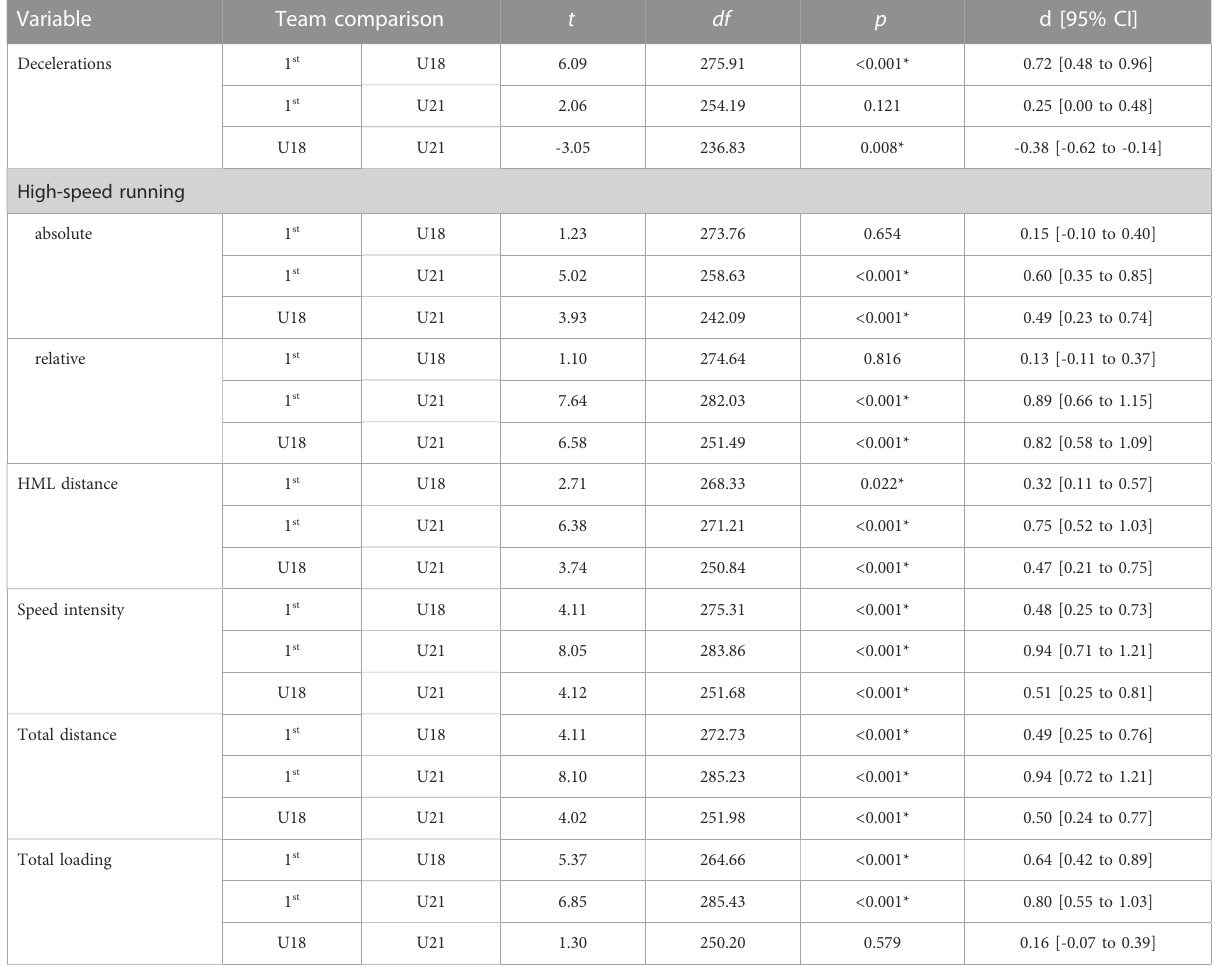
TABLE 8 T-tests (with Bonferroni corrections) comparisons between teams for selected external load measures. Con fi dence level of the d con fi dence intervals = 0.95. Level of signi fi cance: * p < 0.05.